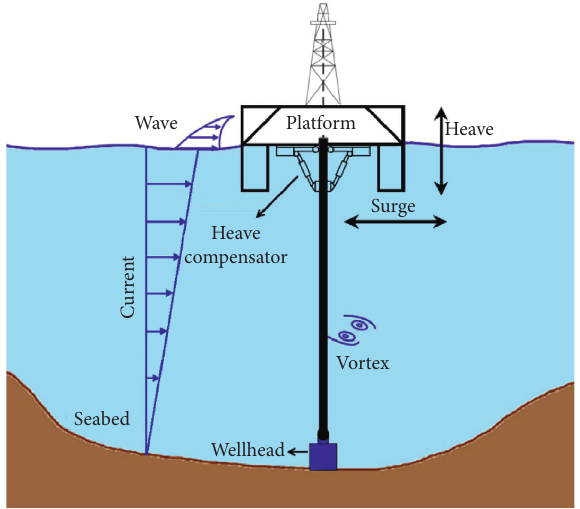
Figure 1: Schematic of a top-tensioned riser in ocean